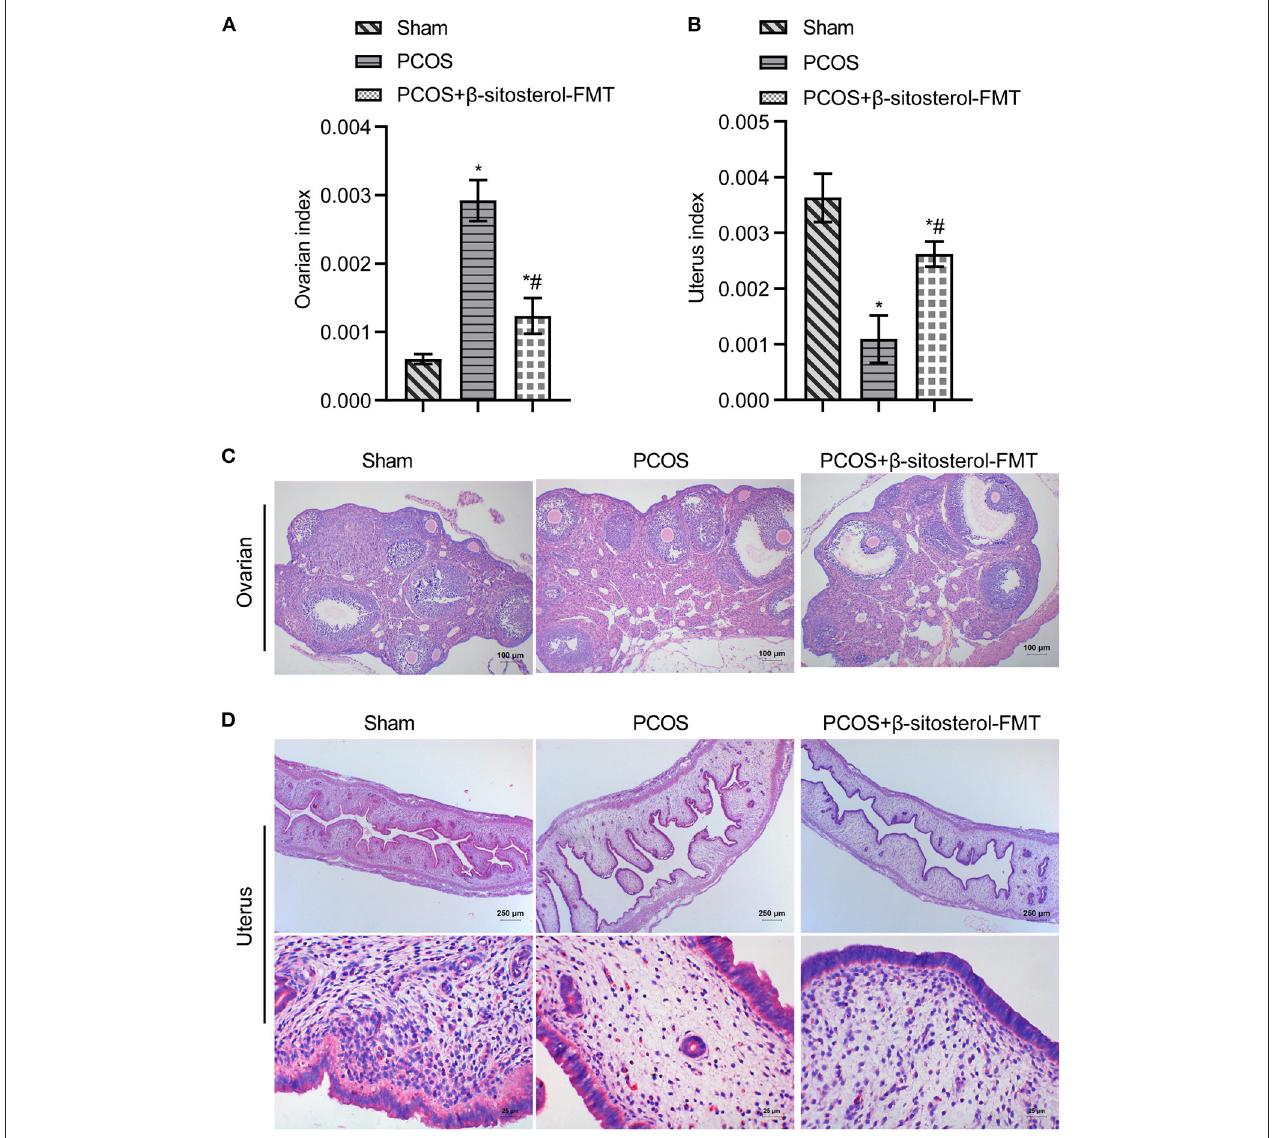
FIGURE 6 | Effects of β -sitosterol-FMT on ovaries and uterus in mice with PCOS. (A) Ovarian index. (B) Uterine index. (C) Hematoxylin and eosin (H&E) staining showed pathological changes of ovarian tissue in each group. Images are magnified 100-fold (scale bar = 100 µ m). (D) HE staining showed pathological changes of uterine tissue in each group. Upper images are magnified 40-fold (scale bar = 250 µ m), and underneath images are magnified 400-fold (scale bar = 25 µ m). Data are presented as mean ± SEM. * P < 0.05 vs. Sham. # P < 0.05 vs. PCOS. PCOS, polycystic ovary